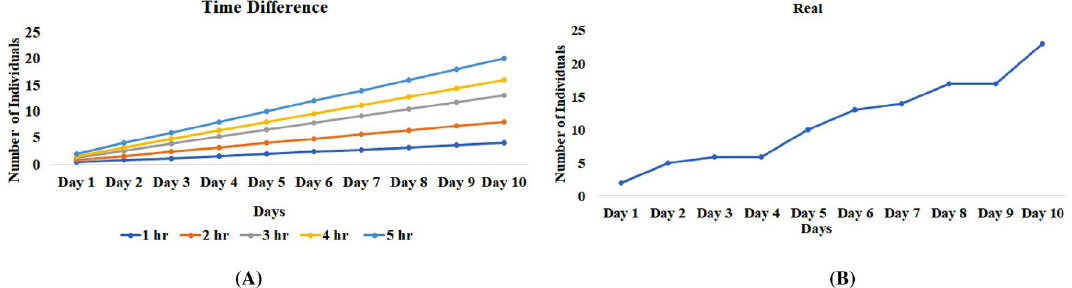
Figure 3. Time difference graphs (TDG): TDG shows that if we increase the time such as 1 h, 2–5 h. of the sampling there is an increase chance of getting more sample from the hospital. Therefore, represent a direct relationship of sample availability and time. In the second graph i.e., Real graph, which represent fluctuation in sample availability at each day, which reflect that we would never receive the exact number of samples as predicted by the model thus, represent the real-world diversity. But it helps us to set a threshold of sample availability from a single hospital with specific time